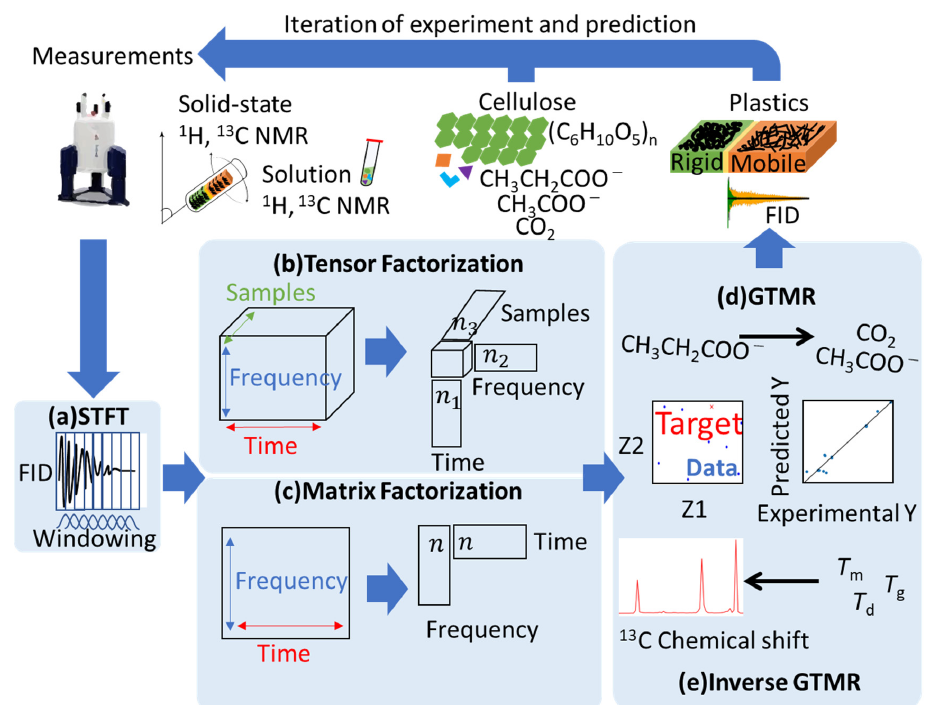
Figure 1. Concept diagram of a material development cycle based on signal deconvolution and prediction for the solid-state nuclear magnetic resonance (ssNMR) of multi-component materials. ( a ) Free induction decay (FID) is transformed into a dataset with time and frequency axes by short-time Fourier transform (STFT). ( b ) In the case of a three-dimensional dataset such as one with multiple samples and conditions, the FID is separated into each component based on the factors of time, frequency, and samples (or condition) by tensor factorization. ( c ) In the case of two-dimensional datasets such as a matrix with time and frequency axes, the FID is separated into each component based on factors of time and frequency by matrix factorization. ( d ) The generative topographic mapping regression (GTMR) accurately predicted the cellulose degradation process shown by catabolic products such as acetate and CO 2 . ( e ) Forward prediction and inverse prediction of GTMR were used to compute the STFT-processed NMR (STFT–NMR) signals from the physical properties of the plastics. This approach is an iterative procedure to achieve convergence between experimental and predicted spectra.